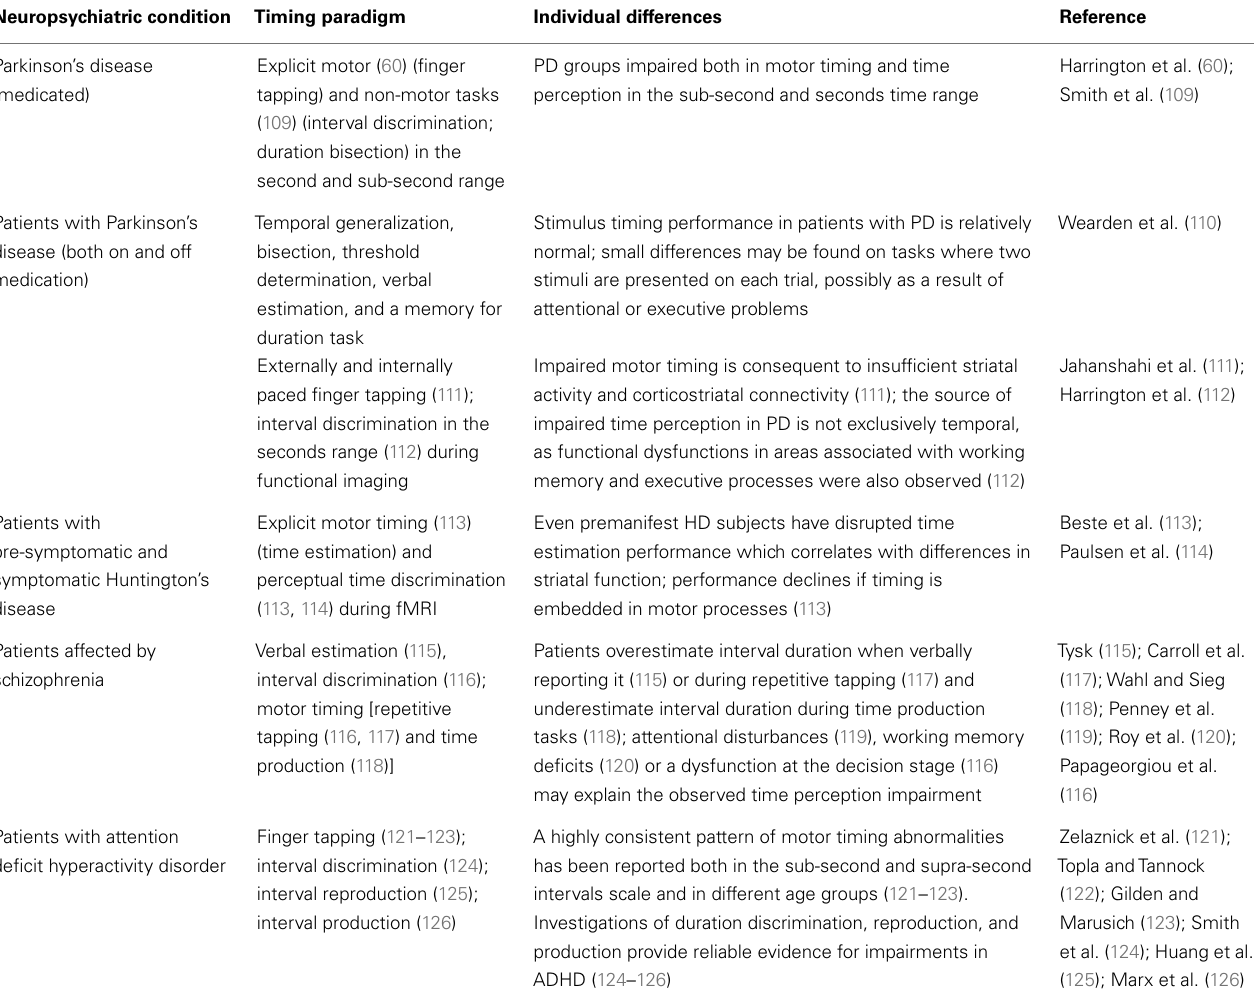
Table 1 | Representative studies reporting pathophysiological distortions in time perception and timed performance in neuropsychiatric